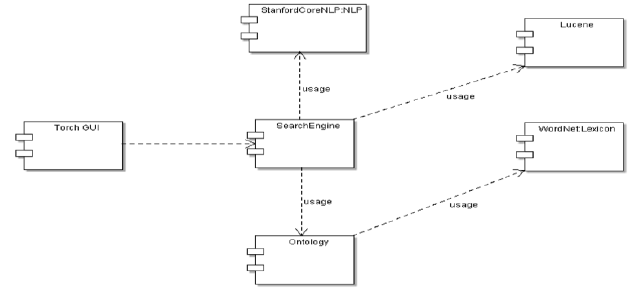
Fig. 6. Component diagram for the Law-Torch system.